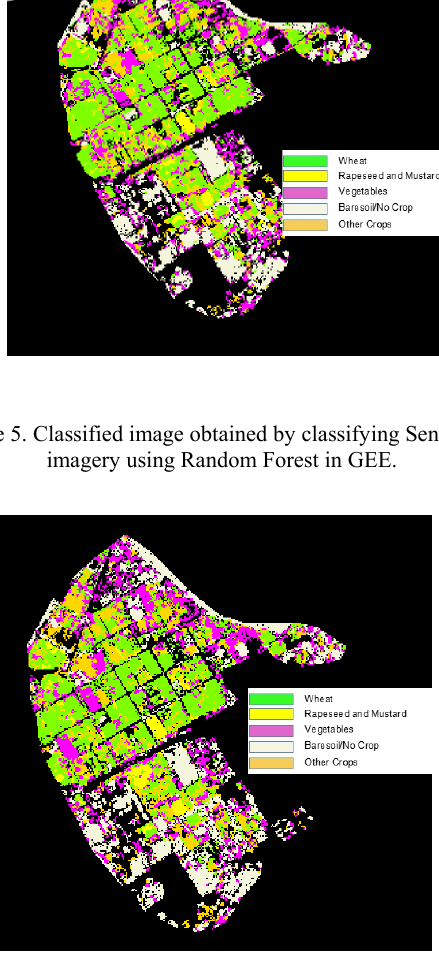
Figure 6. Classified image obtained by classifying Sentinel-2 imagery using SVM in